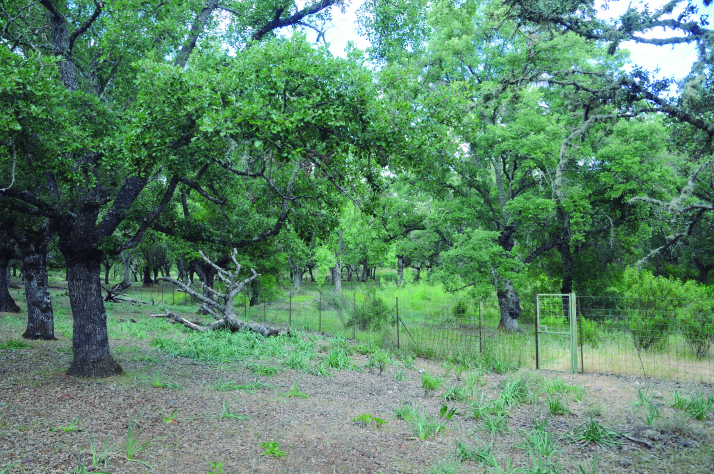
C3 plot La Quesera, Q.
faginea forest